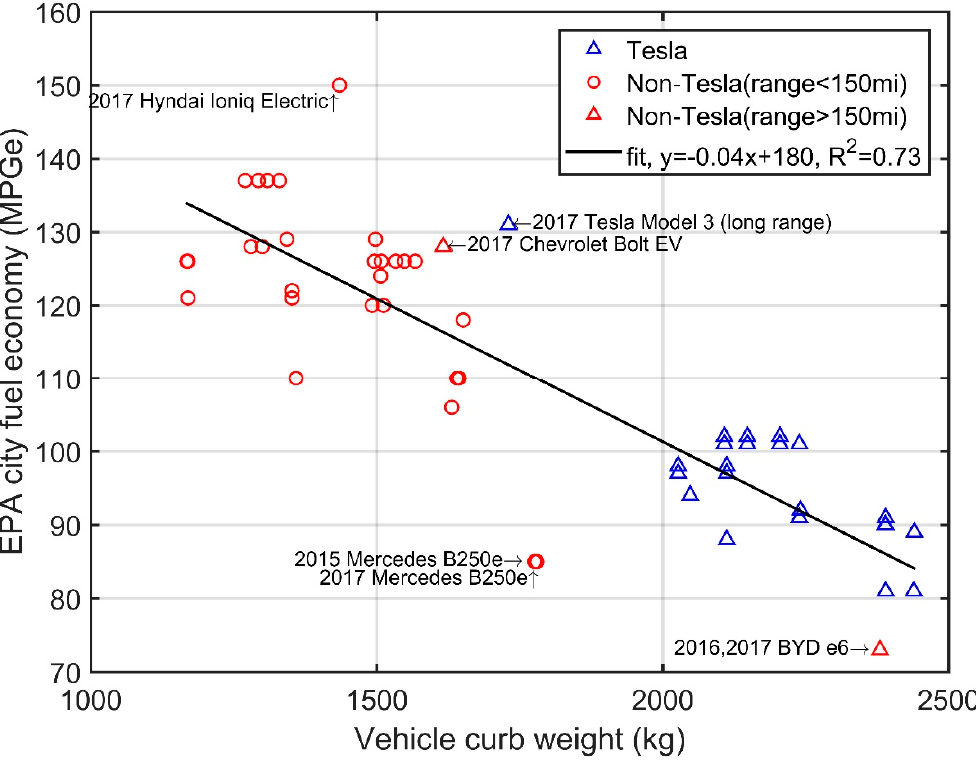
Figure 2. Scaling trend of EPA city (MPGe) fuel economy with vehicle curb weight (kg). Blue represents Tesla vehicles, red represents non-Tesla vehicles, circle represents short-range BEVs, and triangle represents long-range BEVs.